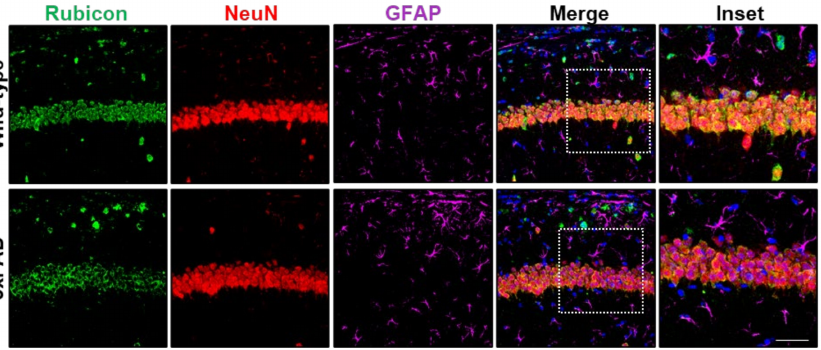
Figure 3. Rubicon is detected in neurons in hippocampal sections of wild-type and 5xFAD mice at the symptomatic stage (6 months old). Z-stack of confocal images detecting Rubicon (green), the neuron marker NeuN (red), and the astrocytic marker GFAP (purple) by immunofluorescence. Nuclei are stained with DAPI. Images are representative of at least four animals for each genotype. Scale bar: 50 µ m, Inset: Scale bar: 20 µ